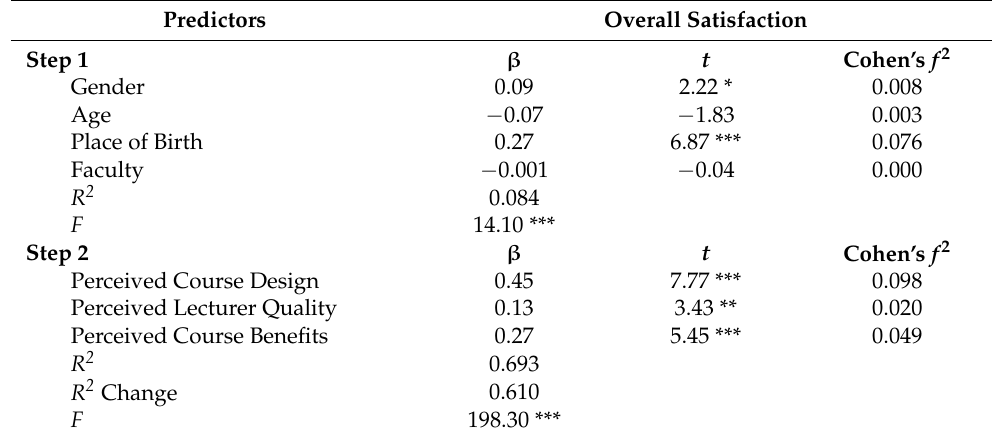
Table 4. Impact of perceived course design, lecturer quality and course benefits on overall satisfaction.